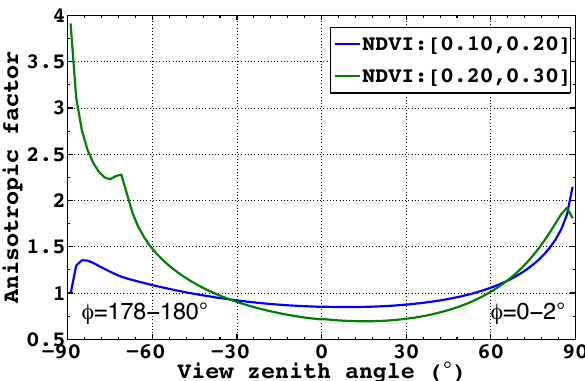
Figure 10. CERES clear-sky SW anisotropic factors in the principal plane for a region centered at 49.5 ◦ N and − 119.5 ◦ W in January for θ 0 = 70 ◦ and all available NDVI bins. The IGBP surface type for NDVI between 0.1 and 0.2 is fresh snow, and the IGBP surface type for NDVI between 0.2 and 0.3 is evergreen needleleaf forest. Anisotropic factors are derived based on 60 months of CERES Terra measurements over clear CERES